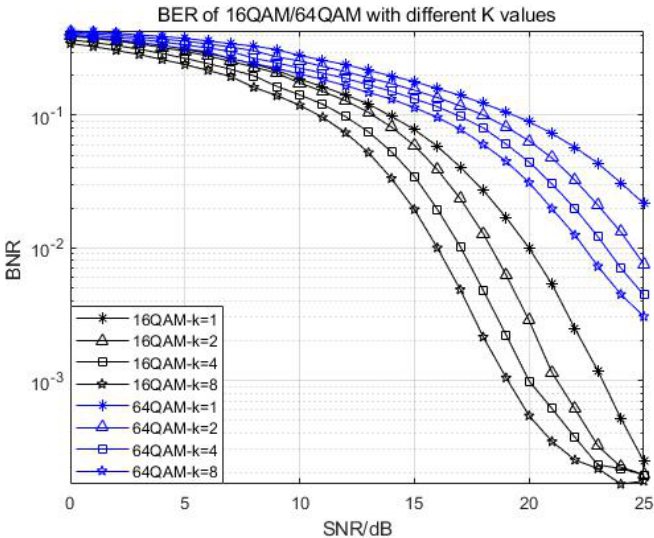
Figure 3. BER of 16-QAM and 64-QAM demodulation with different K values.